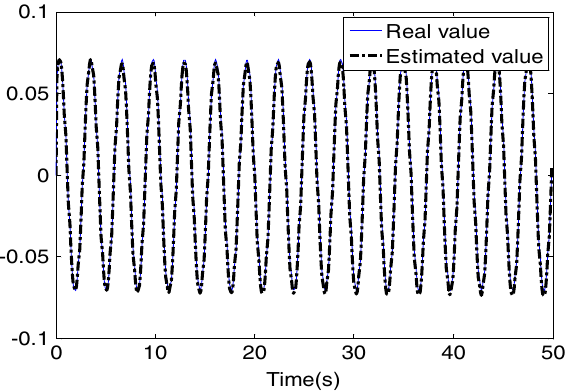
Figure 6. Disturbance curve and its